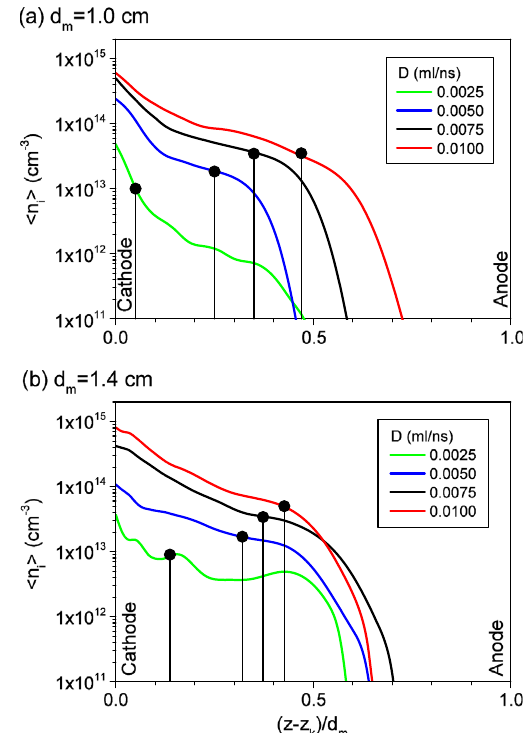
FIG. 6. (a) Estimated effective AK gap ( d E m ) from simulations with different plasma desorption rates, D . (b) Scaling of the simulated sheath current in the MITLs upstream of the convolute as a function of d E m